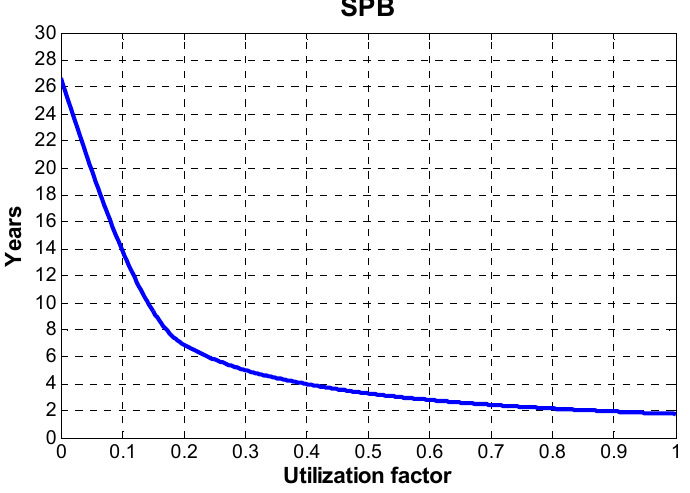
Figure 13. SPB in function of the utilization factor of thermal